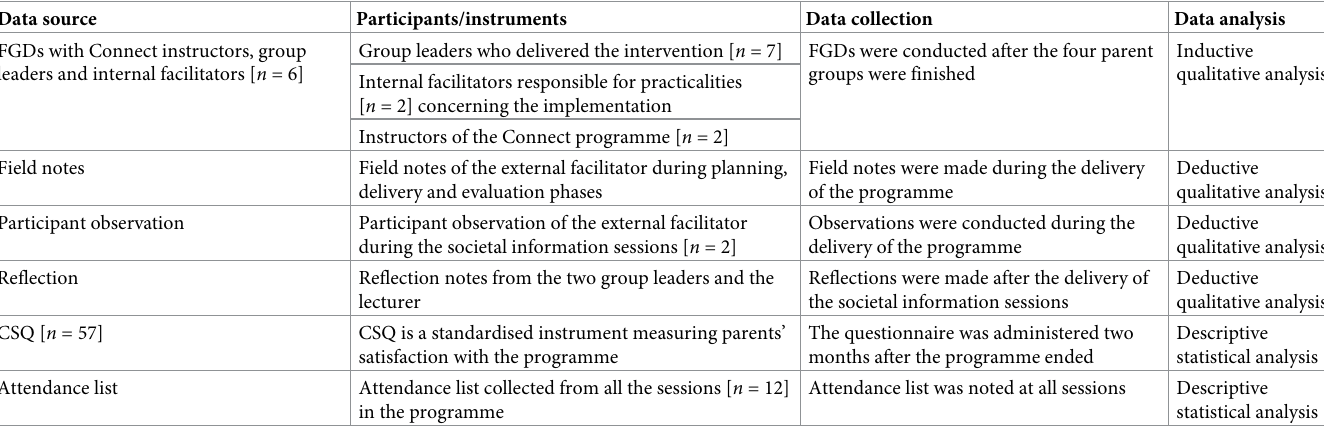
Table 3. Data collection sources, participants and data